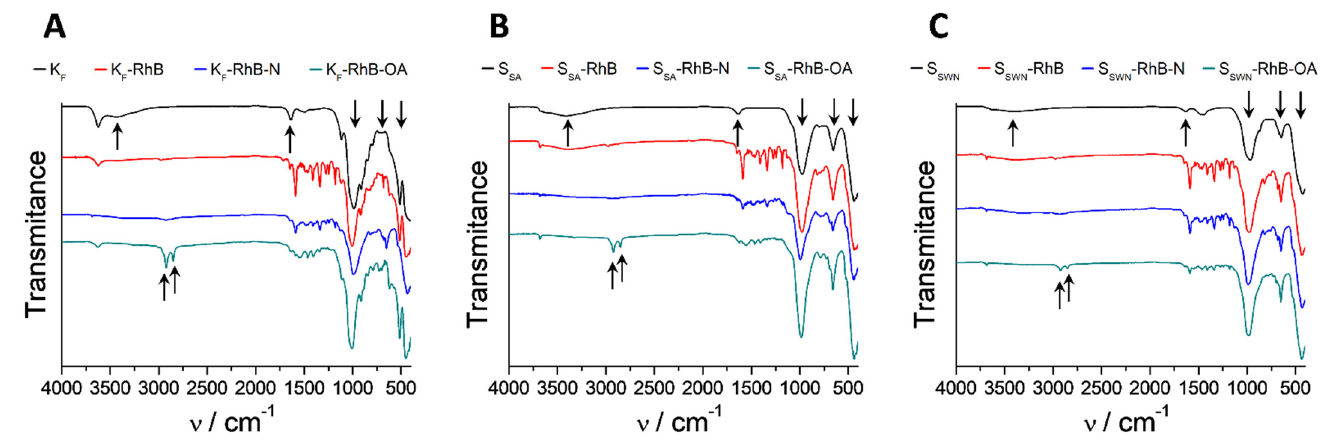
Figure 5. FTIR spectra of the consecutive synthesis steps of the different model organonanoclays: ( A ), K F -RhB-OA; ( B ), S SA -RhB-OA; ( C ), S SWN -RhB-OA.